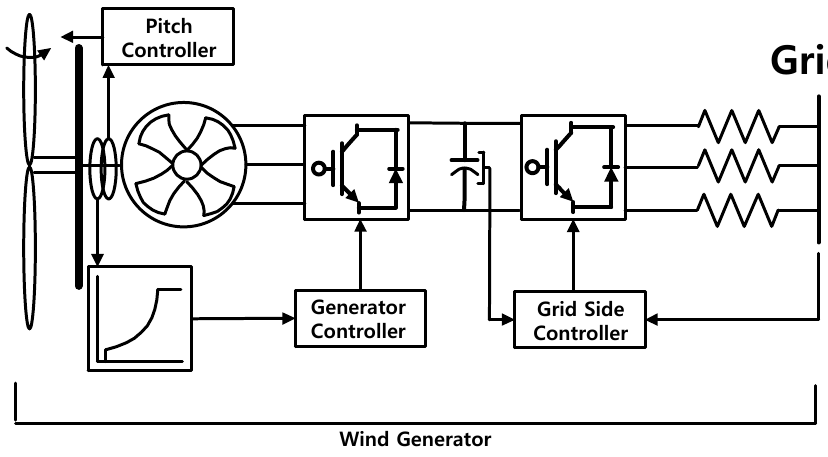
Figure 1. The control of the wind generator.